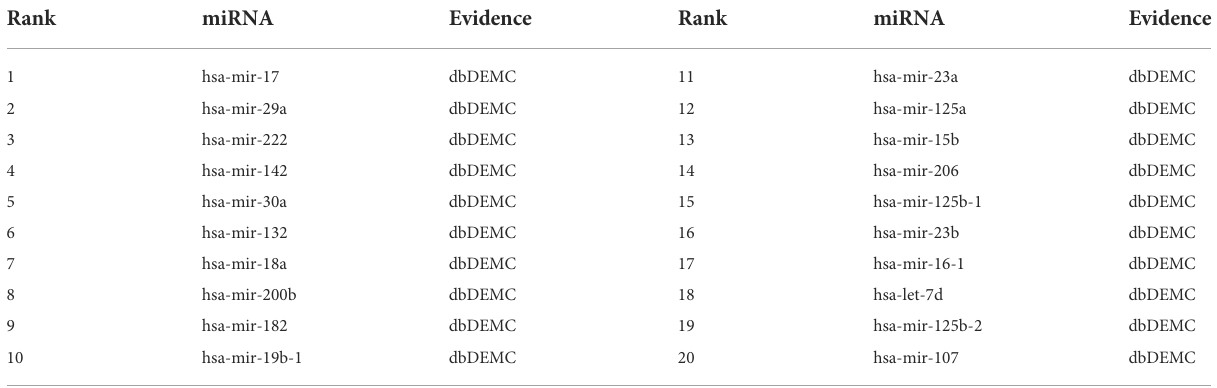
TABLE 5 Top 20 miRNA candidates related to esophageal neoplasms. Rank